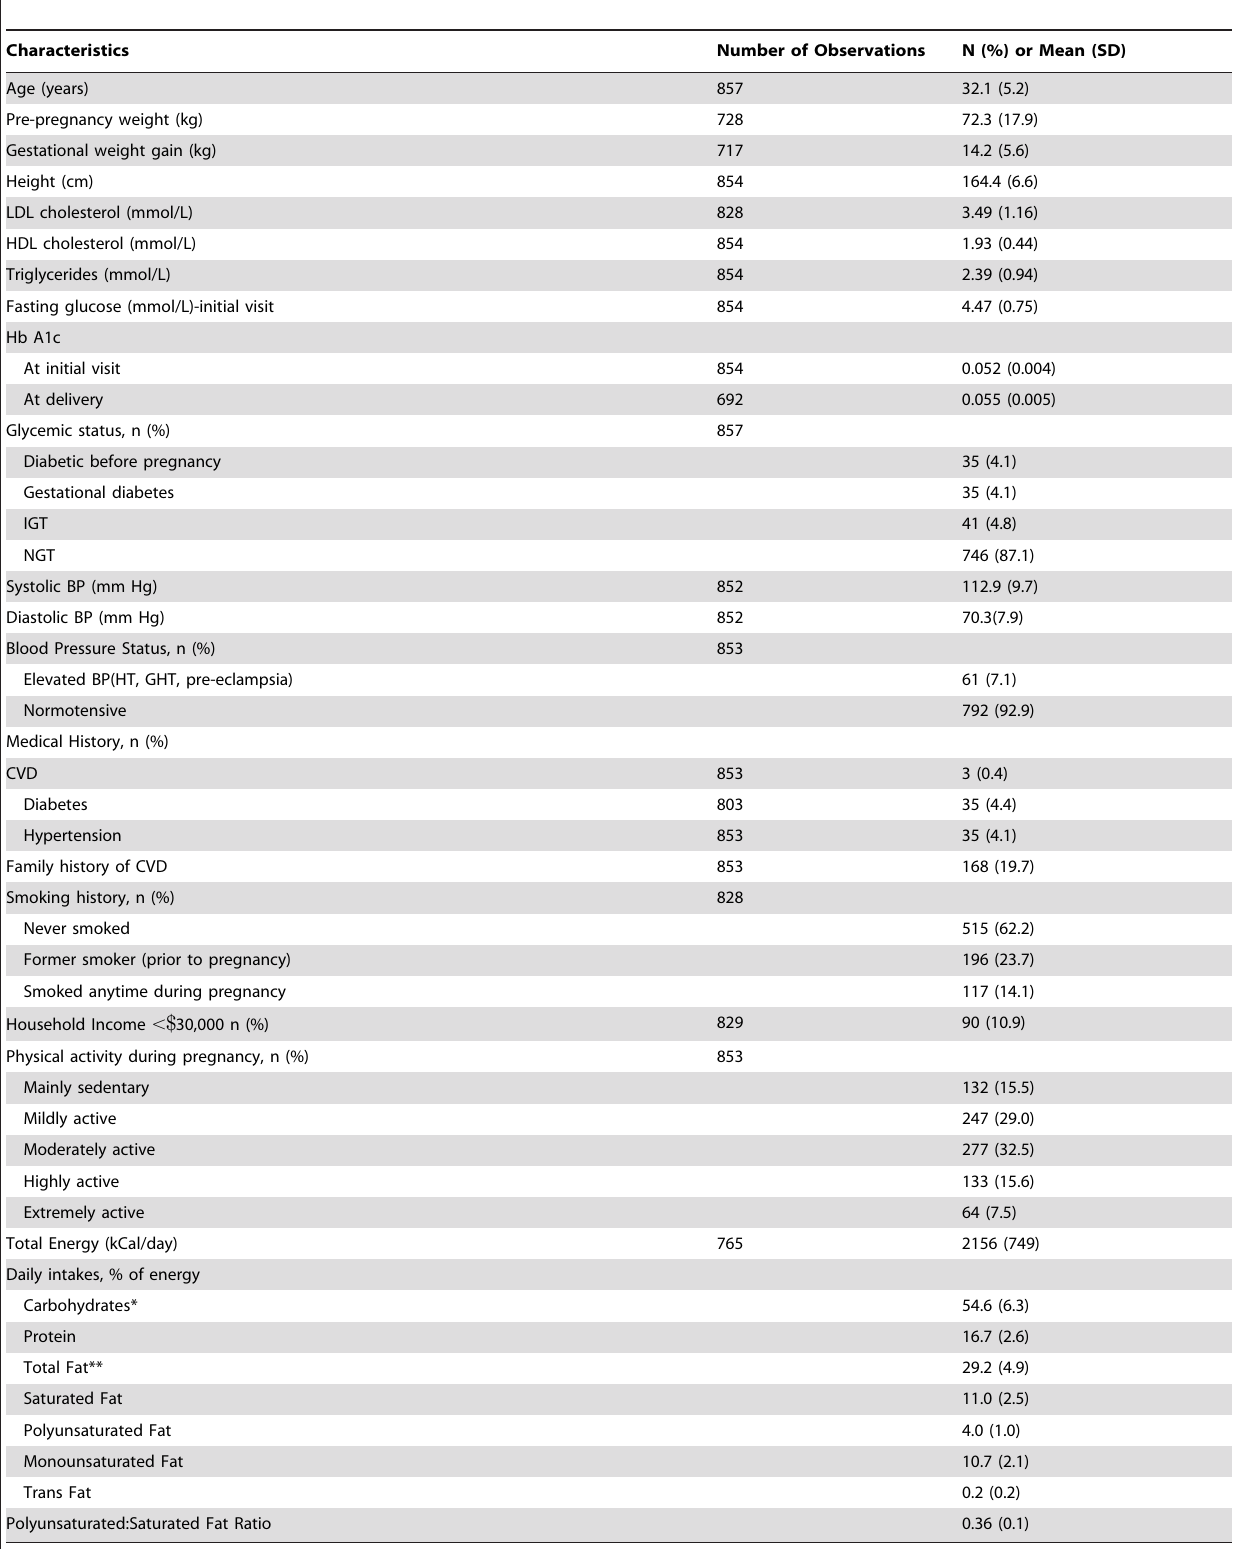
Table 1. Demographic characteristics and biochemical measures (mean and SD) for pregnant mothers at initial visit and after